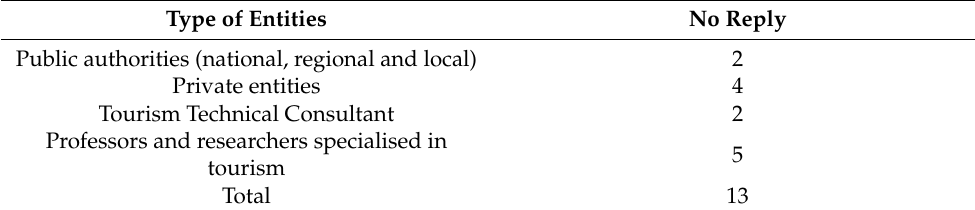
Table 3. Contacts made but no response. Source: Own realisation.